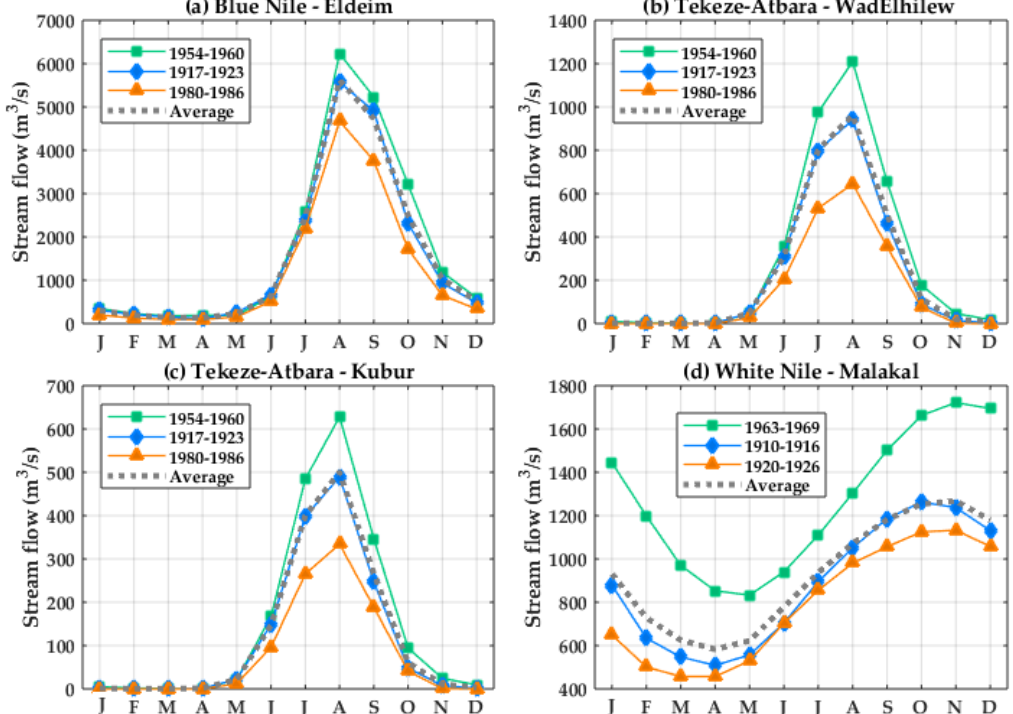
Figure 5. Consecutive dry, normal and wet periods with average flow of Tekeze–Atbara River, the Blue and White Nile, estimated from 103-year monthly flow data (e.g., January = month 1).